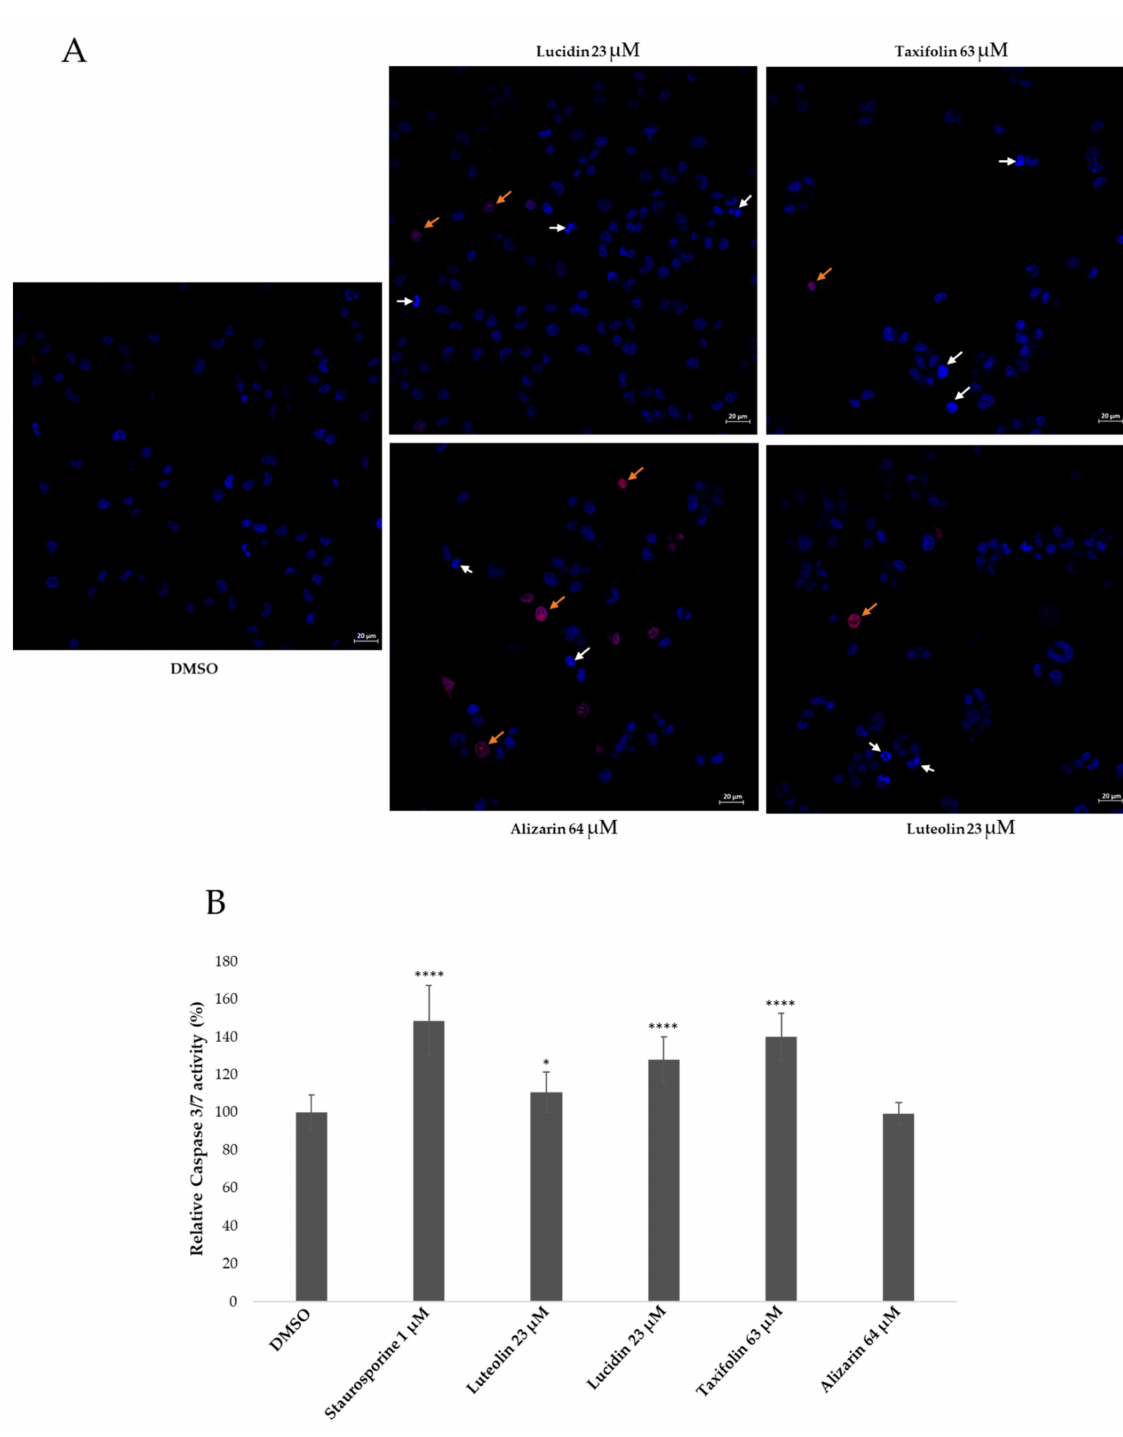
Figure 7. Effect of anthraquinones and flavonoids on nuclear morphological changes of HeLa cells at 48 h treatment ( A ). Cells were stained with Hoechst 33,342 and PI and observed with a fluorescence microscope under a magnification of 40 × . Effect of anthraquinones and flavonoids on the caspase activity of HeLa cells, determined after 48 h of contact by the Caspase 3/7-Glo assay ( B ). DMSO- treated cells were used as a negative control, while incubation with 1 µ M of staurosporine for 48 h was used as a positive control. Data are presented as mean ± SD, n = 3 (three independent experiments) and analyzed by the t -Student test. Significance was determined as p -values * < 0.05, **** <